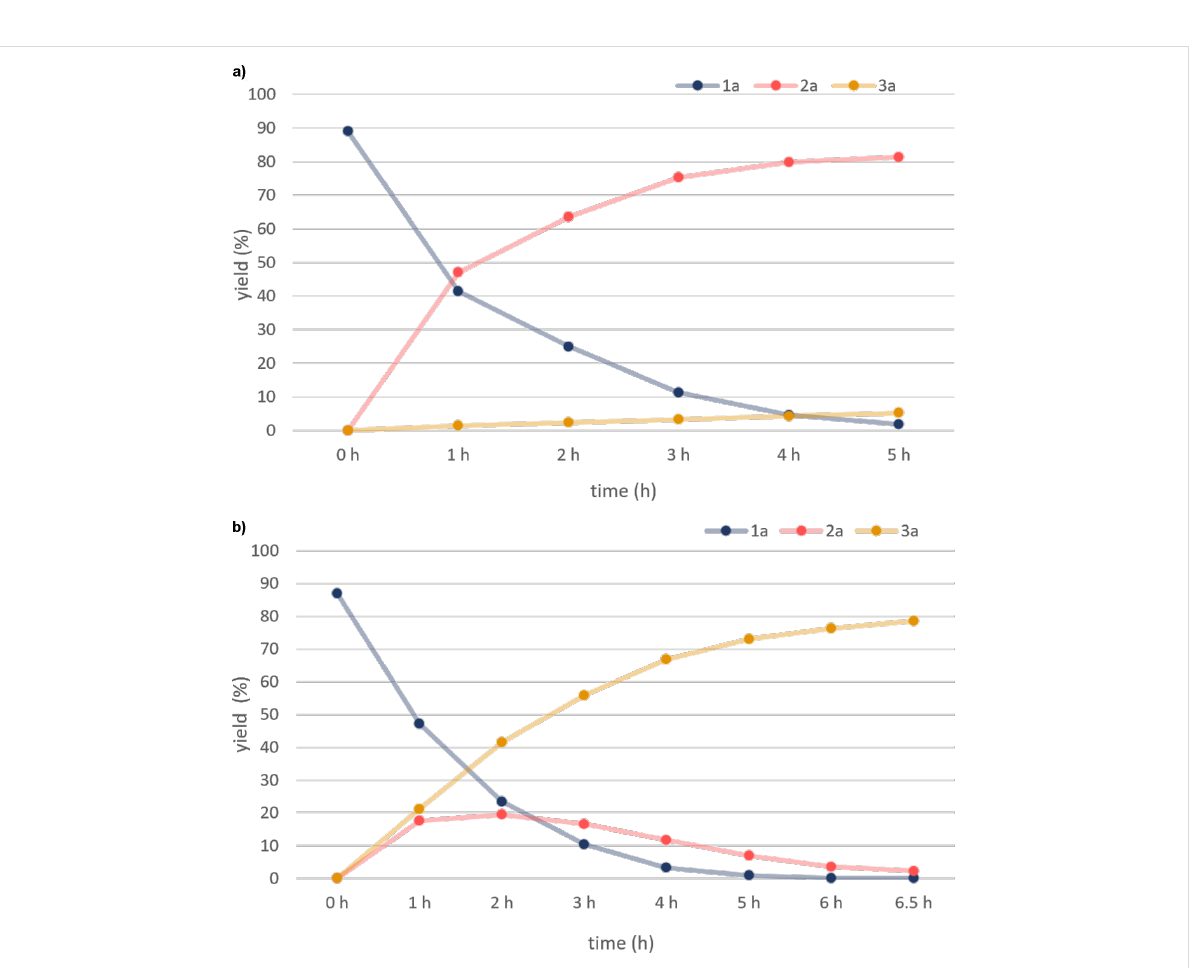
Figure 2: Reaction profile of the electrochemical hydrogenation of 1a with a PEM reactor using a) Pd/C and b) Ir/C cathode catalyst. The yield of 2a and 3a and the recovery of 1a are shown in red, brown, and blue,